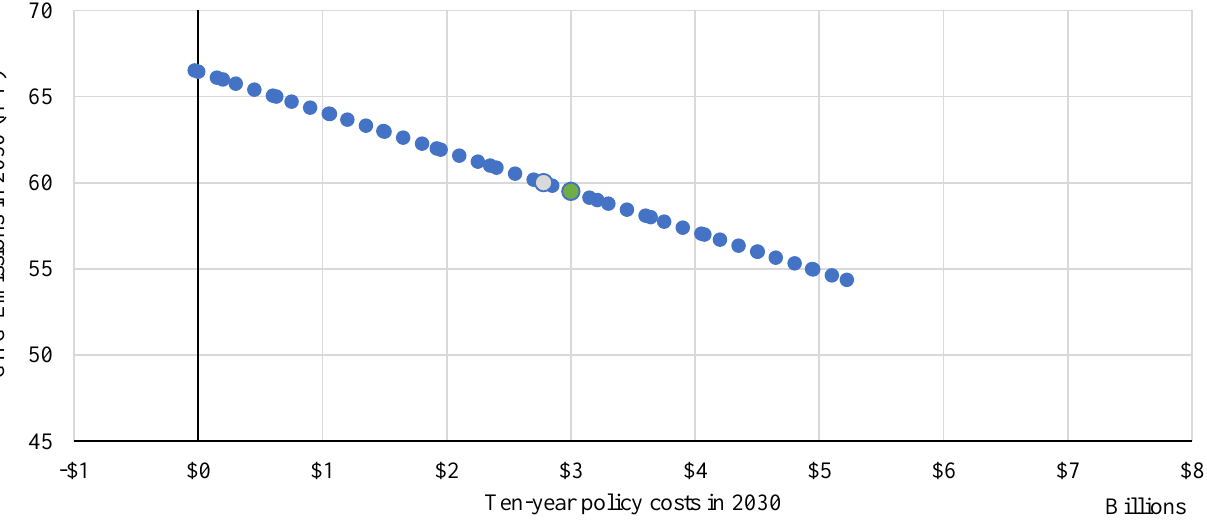
Figure A3. Pareto front 3 calculated from the MIO model. Assumes LDV fleet is 25% EV in 2030 (low-EV) and upper-bound TCO (high-TCO). Green and grey points represent the two policy scenarios (~3$ billion ten-year policy costs in 2030 and 40% GHG reduction relative to 2005 levels in year 2030) presented in Section 4.